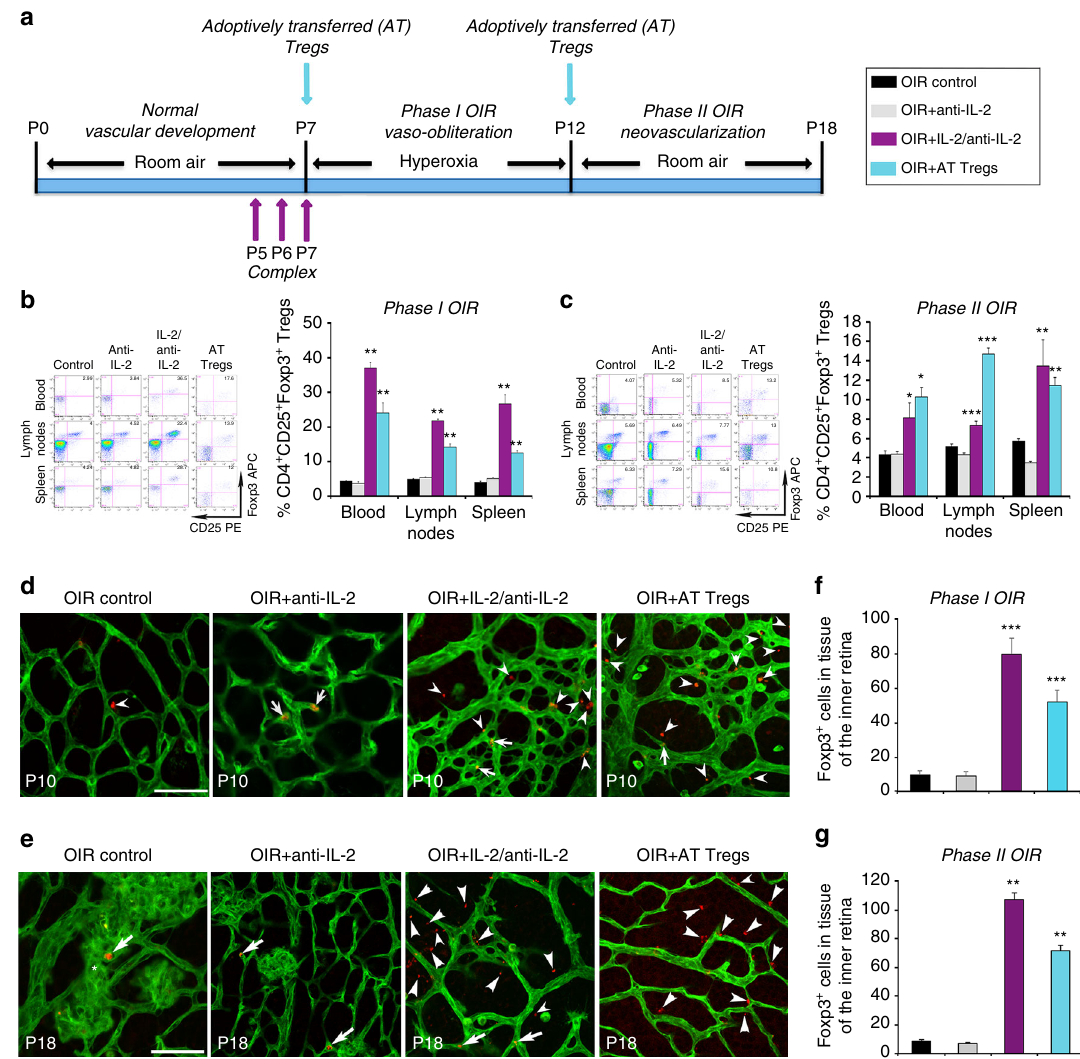
Fig. 2 Expanding Treg numbers increased their abundance in OIR and retina. a C57BL/6J mice were administered an IL-2/anti-IL-2 mAb complex at postnatal day ( P ) 5, P6, and P7. Separate cohorts of OIR mice received puri fi ed splenic Tregs by adoptive transfer (AT) at P7 and P12. Mice were studied in phase I OIR and phase II OIR and comparisons made to age-matched OIR control mice or OIR mice administered an anti-IL-2 control mAb. FACS revealed that in phase I OIR at P12 b and phase II OIR at P18 c the numbers of Tregs in blood, pooled lymph nodes, and spleen were increased with both treatments (enlarged FACS plots in Supplementary Fig. 3). Fluorochromes are phycoerythrin PE) and allophycocyanin (APC). * P < 0.05, ** P < 0.01, and *** P < 0.001 to OIR controls and OIR + anti-IL-2 mAb controls (one-way ANOVA with Mann – Whitney U test). n = 6 mice/OIR control and OIR + anti-IL-2 group and 7 mice/OIR-treated group at P12 and P18. Representative confocal images of fl at mounted retinas from Foxp3 rfp mice labeled with isolectin ( green ) to show blood vessels. In phase I OIR at P10 d and phase II OIR at P18 e , few Foxp3 + cells ( red ) were present in retinal tissue and ( arrowhead ) and blood vessels ( arrows ). Asterisk denotes neovascular tuft. In OIR-treated groups, Foxp3 + cells were increased in retinal tissue ( arrowheads ). Scale bar , 50 μ m. f , g Foxp3 + cells in tissue of the inner retina (one-way ANOVA with Mann – Whitney U test). ** P < 0.01 and *** P < 0.001 to OIR control groups. n = 13 mice/OIR control group and 9 mice/OIR-treated group at P10. n = 12 OIR mice, 9 OIR + anti-IL-2 mice and 7 mice/OIR-treated groups at P18. Values are expressed as mean ±